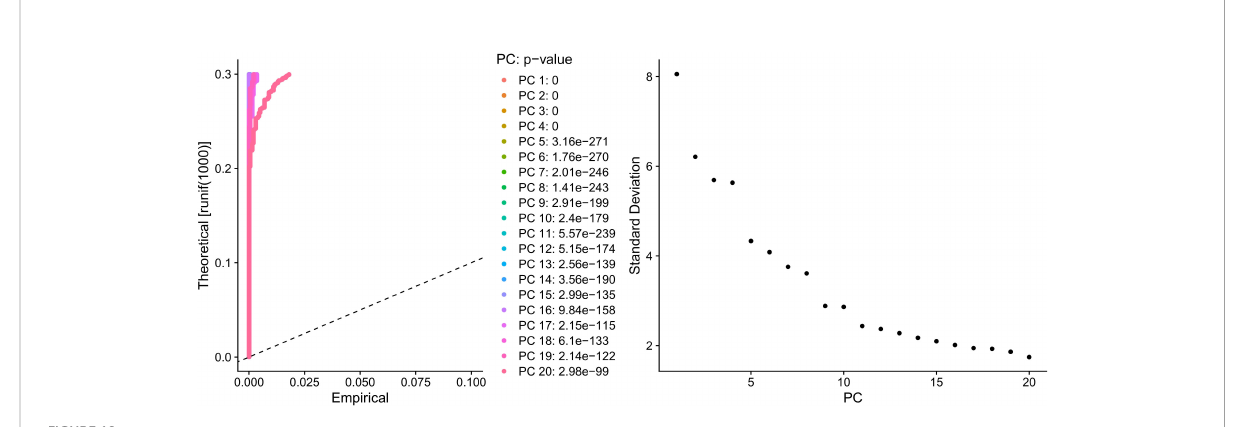
FIGURE 10 Dimensionality reduction results of PCA for 2000 hypervariable genes.